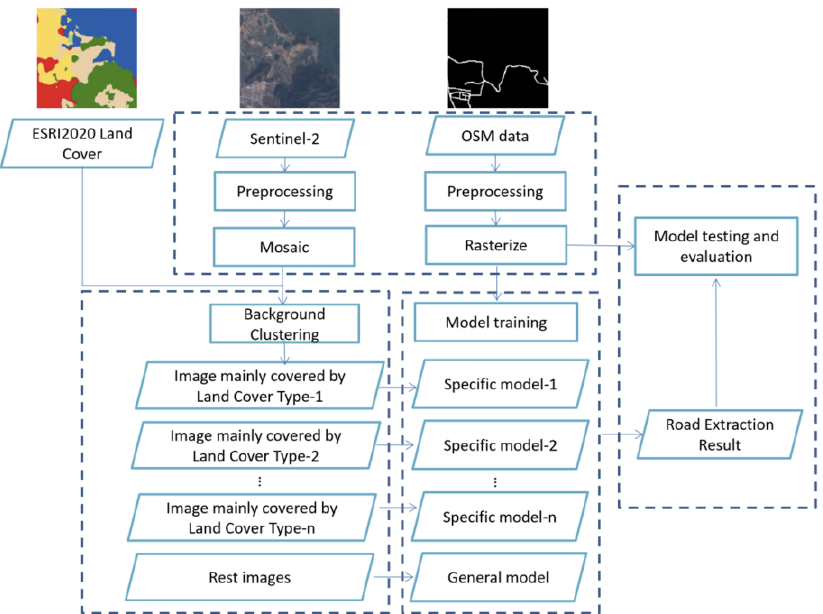
Figure 3. The framework of the proposed background-adaptive framework for large-scale road ex- traction.